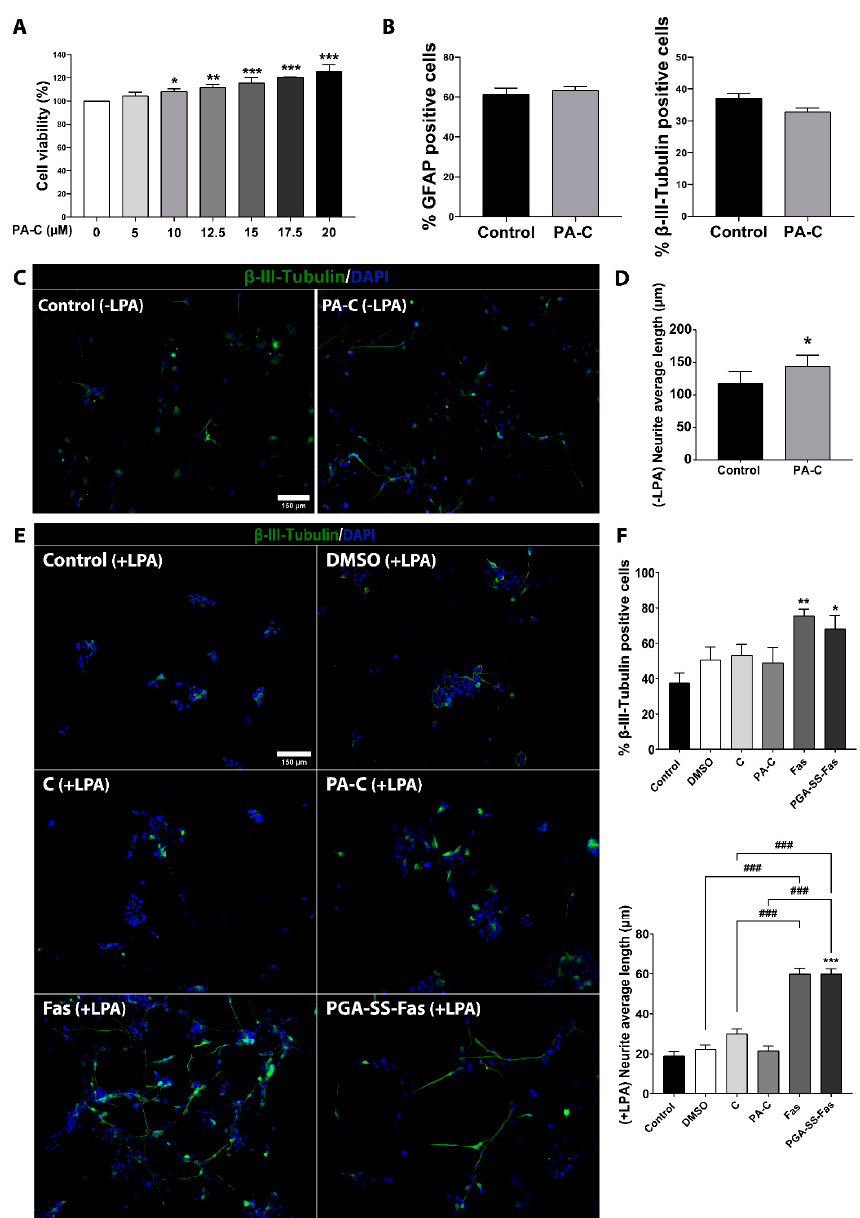
Figure 2. ( A ). Effect of PA-C treatment on iPSC-NSC viability and neurite outgrowth in vitro. ( A ). Cell viability evaluations of iPSC-NSC treated with increasing concentrations (5, 10, 12.5, 15, 17.5, and 20 µ M) of PA-C for 24 h. Values represented as a percentage relative to vehicle-treated control iPSC-NSC. Data expressed as mean ± S.E.M. of three independent experiments determined by one-way ANOVA with Dunnett’s multiple comparison test (* p < 0.05, ** p < 0.01, *** p < 0.001 vs. control). ( B ). Immunofluorescence quantification of the percentage of iPSC-NSC positive for astroglial (GFAP; left panel) and neuronal ( β -III-Tubulin; right panel) markers after treatment with 10 µ M PA-C for 24 h. ( C ). Representative images of immunofluorescence staining of β -III-Tubulin (green) and nuclear DAPI staining (blue) (scale bar = 150 µ M). ( D ). Quantitative analysis of neurite elongation in iPSC-NSC treated with 10 µ M PA-C for 24 h. Data represented as average neurite length ( µ m) and expressed as mean ± S.E.M. of three independent experiments determined by unpaired Student’s t-test (* p < 0.05 vs. Control). ( E ). Representative images of immunofluorescence staining of β -III-Tubulin (green) and nuclear DAPI staining (blue) (scale bar = 150 µ m). ( F ). Quantitative analysis of neurite elongation in iPSC-NSC pre-treated with 10 µ M PA-C or 50 µ M PGA-SS-Fas for 24 h and then treated with LPA for a further 24 h. Data represented as average neurite length ( µ m). Data expressed as mean ± S.E.M. of three independent experiments determined by one-way ANOVA with Tukey’s multiple comparison test and unpaired Student’s t -test (* p < 0.05, ** p < 0.01, *** p < 0.001 vs. Control; ### p < 0.001 as